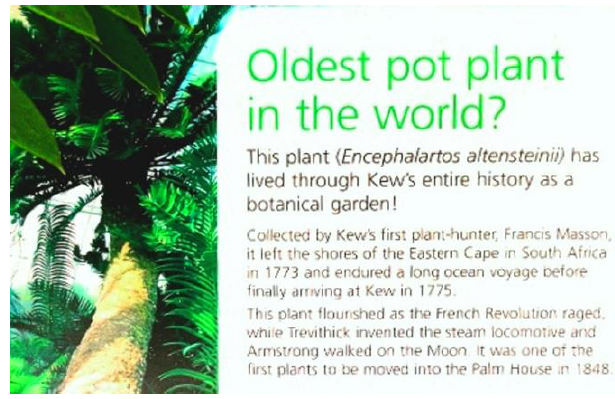
Figure 2. The oldest potted plant in the world is in the “living laboratory” of the Royal Botanical Gardens in Surrey (Kew